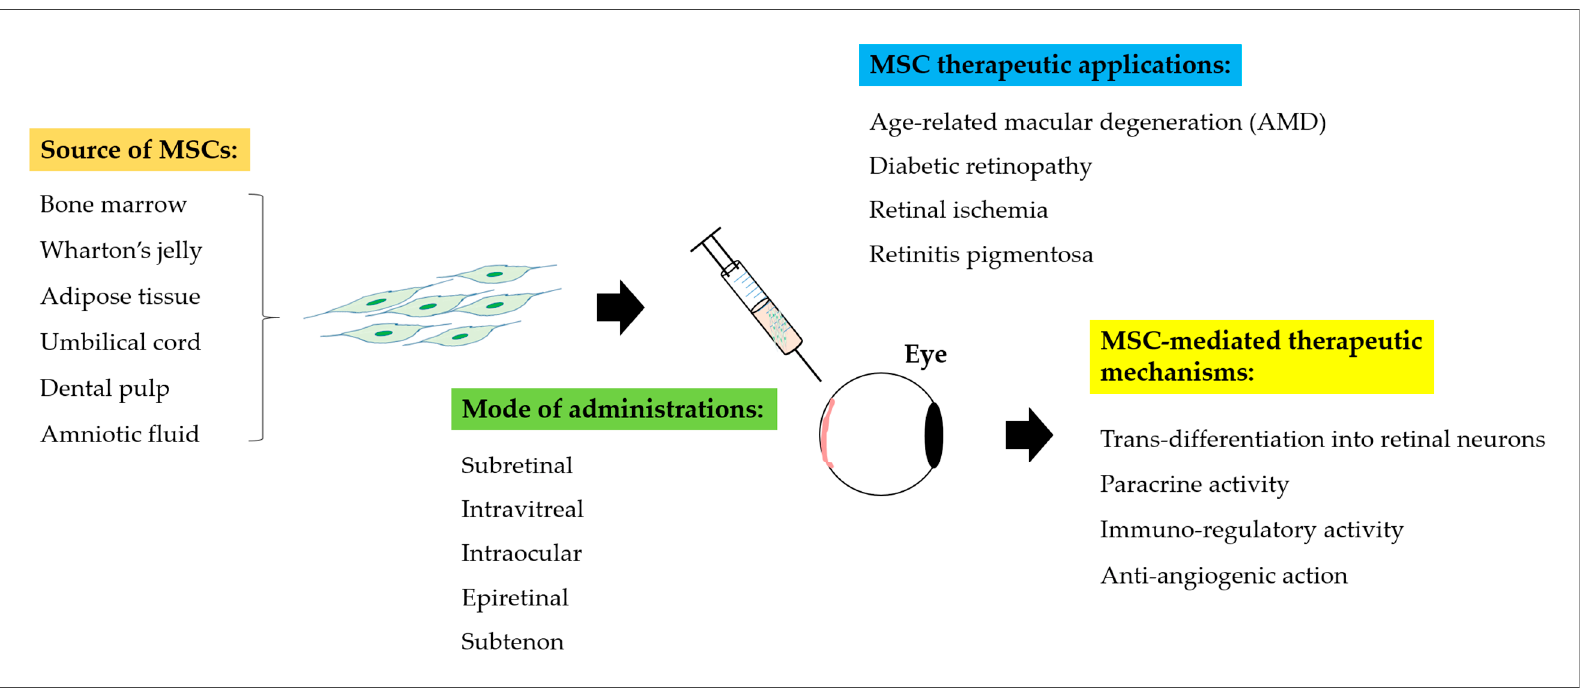
Figure 2. A schematic representation of Mesenchymal Stem Cells (MSCs) therapeutic strategies in retinal degenerative diseases. Different sources of MSC such as bone marrow, Wharton’s jelly, adipose tissue, umbilical cord, dental pulp, and amniotic fluid have been discovered. Multiple routes of administration including subretinal, intravitreal, intraocular, epiretinal or subtenon injections can be implemented to deliver MSCs into the posterior lining of the eye. Delivery of MSCs into patients affected with posterior eye diseases including Age-related Macular Degeneration (AMD), diabetic retinopathy, retinal ischemia, and retinitis pigmentosa can be restored through trans-differentiation, paracrine activity, immuno-regulatory function, and anti-angiogenic action of MSCs.